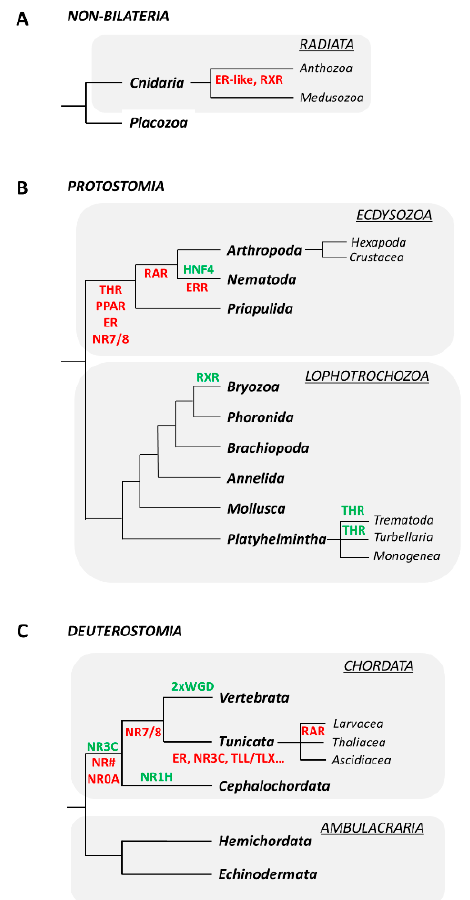
Figure 3. Examples for nuclear receptor (NR) duplications and losses during metazoan evolution. ( A ) Non-bilaterians. ( B ) Protostomes. ( C ) Deuterostomes. Gene expansions are shown in green and gene losses are shown in red. WGD: Whole genome duplications. Animal phylogenies are based on Laumer et al. (2019) [28]. NR nomenclature is as defined in Table 1. Gene losses have also been important for shaping the NR complements of extant metazoans. Ecdysozoans, for example, have lost a whole suite of NRs, including ER, THR, PPAR and NR7/8. RAR was further lost by arthropods and nematodes, and ERR by nematodes only (Figure 3) [24,27,35]. Similarly, within the chordates, NR0A genes have been lost during early diversification of the lineage, tunicates and vertebrates have lost NR7/8, and the tunicates have been subjected to additional NR losses, including, for example, ER, TLL/TLX and NR3C (Figure 3) [14,24,27,31,36]. Despite their presence in all metazoans, NR functions and signaling pathways have primarily been characterized in vertebrates where they were shown to be involved in a